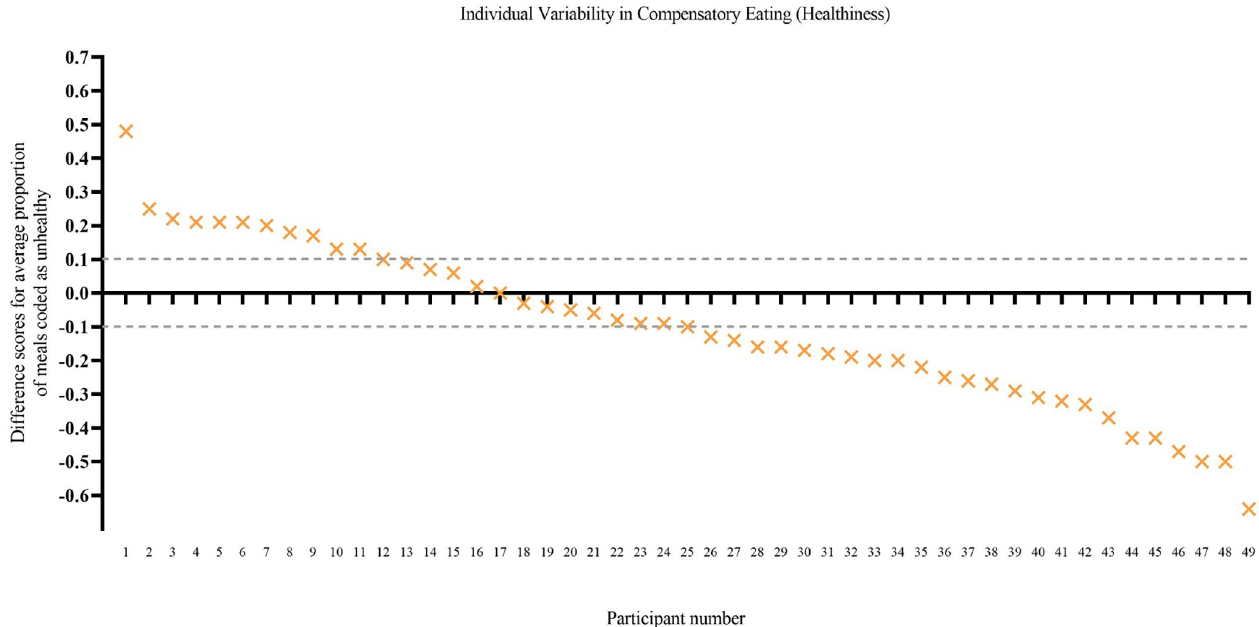
Fig 2. Individual variability in patterns of eating—Healthiness (Study 2). The y axis shows a difference score for each participant: the proportion of post- exercise meals that that were unhealthy minus the proportion of random meals that were unhealthy. A positive score indicates that, on average, the participant consumed a greater proportion of unhealthy meals post exercise than at random meals (i.e., compensatory eating). Dotted lines indicate the boundaries ( ± 0.10) used to mark an eating pattern that was indifferent to exercise (similar proportion of unhealthy meals after exercise and at random meals). Participant scores are ordered in descending order from most compensatory eating to least compensatory eating. Difference scores could only be calculated for 49 of the 55 participants because six did not have any post-exercise meals.